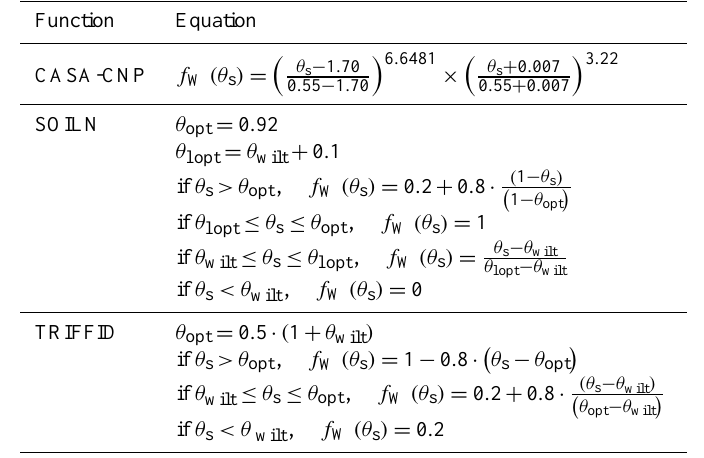
Table 1. Formulations of f W implemented in the CASA-CNP model ( θ s : soil moisture; θ wilt : moisture at wilting point; θ fc : moisture at field capacity; θ opt : optimum moisture; θ lopt : lower optimal moisture – all expressed relative to moisture at